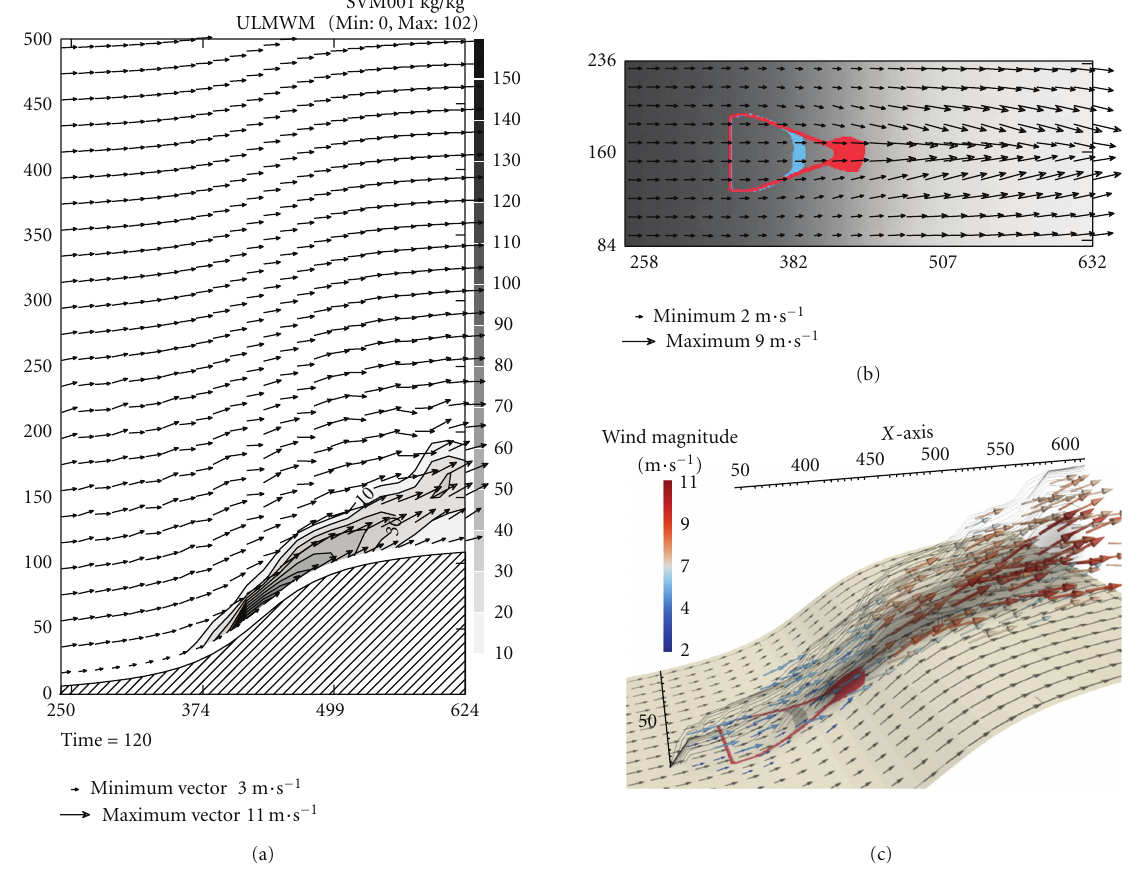
Figure 5: HILL (a) Horizontal section ( x/y ) at Z = 10 m, fire lines after 120 seconds for the coupled (red) and noncoupled (grey) simulations. Arrows denote the wind vectors at ground level for the coupledcase. (b) Cross-section ( x/z ) of the coupled case at Y = 160 m, shading represents concentration of the injected passive tracer. (c) 3d wind field and passive tracer concentration